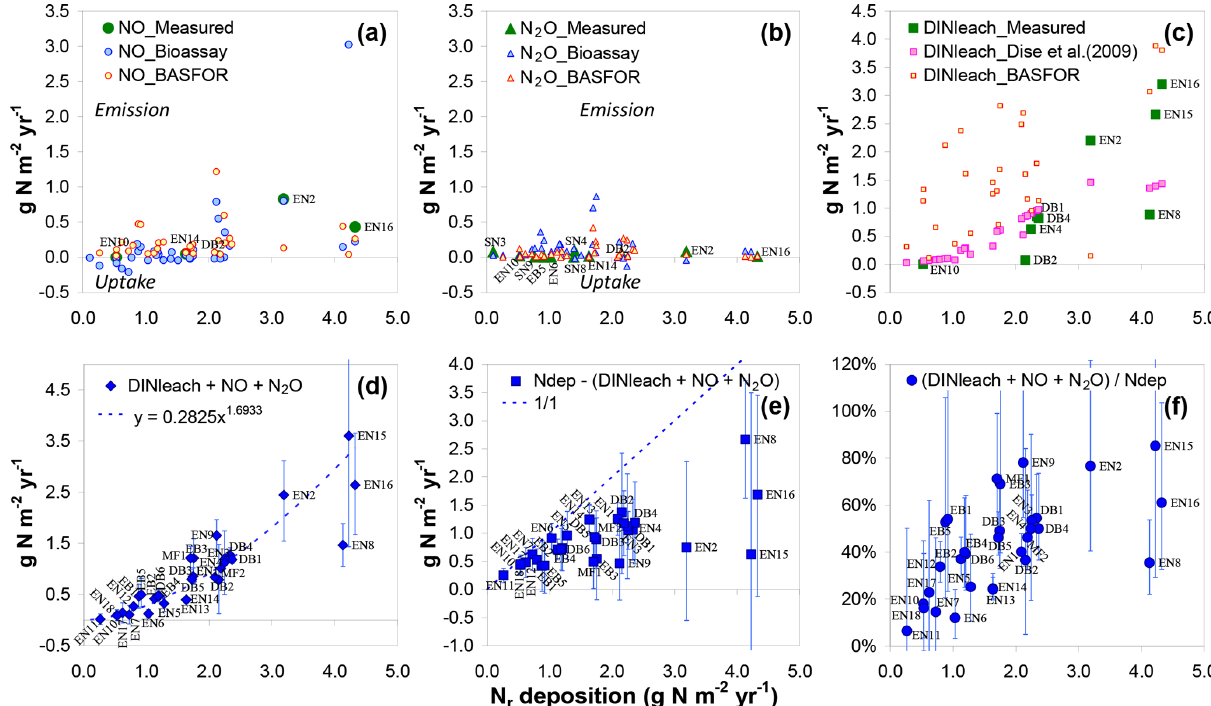
Figure 3. Comparison of measured and estimated ecosystem inorganic N r losses and their relationships to total atmospheric N r deposition ( x axis) at the forest sites. NO fluxes (a) and N 2 O fluxes (b) were either (i) measured in situ using static or dynamic flux chambers, (ii) scaled up from laboratory-bioassay-derived T –WFPS relationships, or (iii) simulated using the BASFOR ecosystem model (see text for details). DIN leaching (c) was either measured (lysimeter or suction cups) or predicted from the Dise et al. (2009) empirical algorithm. The sum of inorganic N r losses (d) (DINleach + NO + N 2 O) was computed as the mean of measured values and modelled estimates. In panels (a) – (c) , site names are indicated for sites where in situ measurements were